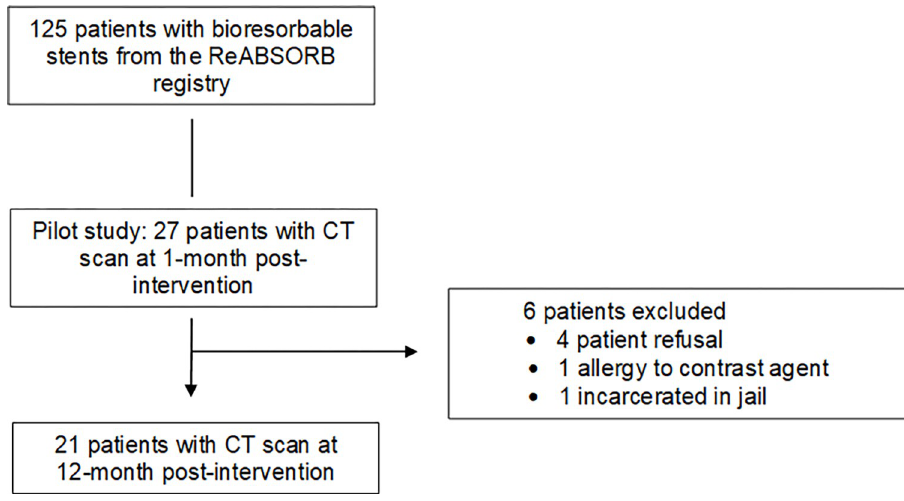
Fig 1. Flow chart of patients bioresorbable coronary stents through the study. All participants were recruited consecutively from the ReABSORB registry. Six participants were excluded. A total of 27 participants underwent a CT evaluation, then 21 underwent a 12-month follow